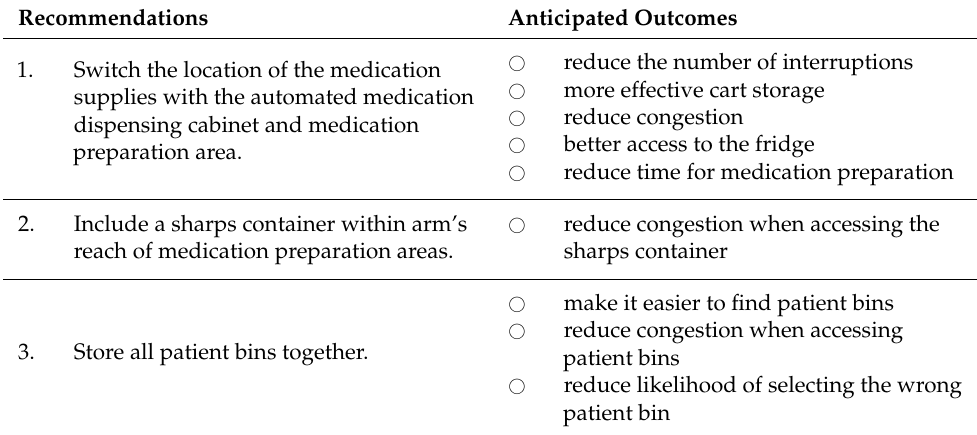
Table 4. Recommended design modifications and associated anticipated outcomes identified through the POE.